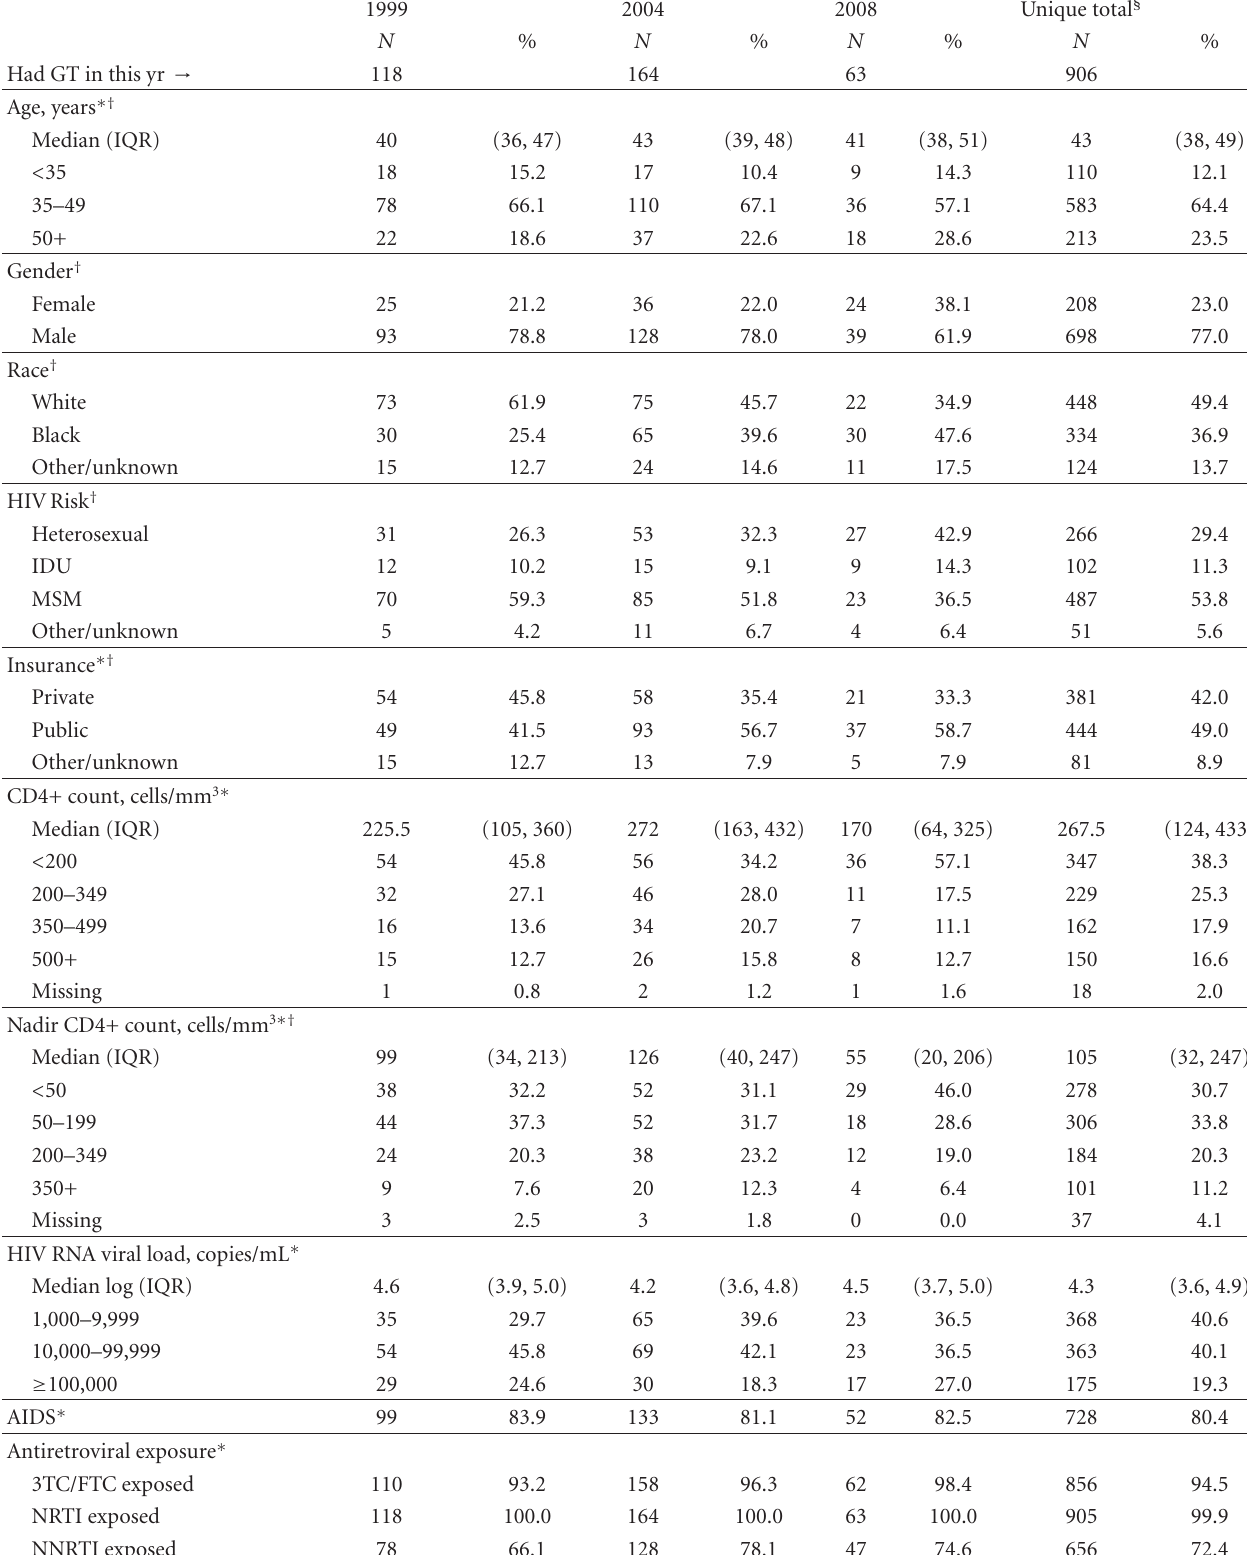
Table 1: Characteristics of ARV-experienced patients who had genotypic testing performed at viral load > 1000 copies/mL and while on ARVs in selected calendar years, and overall, the HIV Outpatient Study,